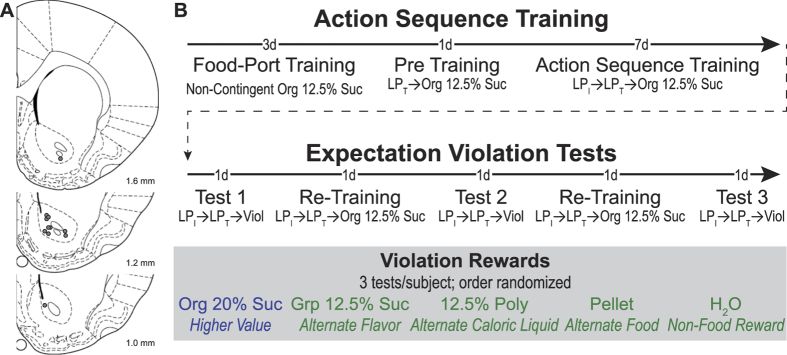
Histological verification of recording sites and experimental design.(A) Coronal section drawings taken from79. These figures were published in The rat brain in stereotaxic coordinates, 4th edn, Paxinos & Watson, 175–177, Copyright Elsevier (1998). Numbers to the lower right represent anterior-posterior distance (mm) from bregma. Gray circles represent electrode placements. 8 actual recording sites were in the right and 3 in the left hemisphere. (B) Behavioral task design. See methods. d: day(s); LPI: Initiating lever press; LPT: Terminating lever press; Org 12.5% Suc: Orange-flavored 12.5% sucrose reward (training reward); Org 20% Suc: Orange-flavored 20% sucrose; Grp 12.5% Suc: Grape-flavored 12.5% sucrose; Poly: Polycose solution; Pellet; grain-based food pellet; H2O: water.